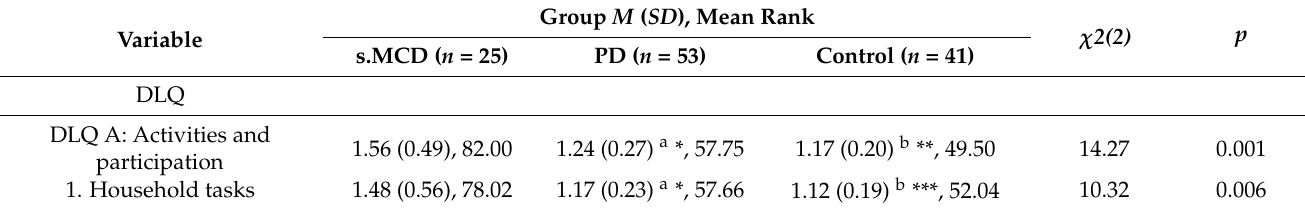
Table 2. Comparison of the DLQ and TOPS scores of the PD patients with (s.MCD group) and without (PD group) suspected mild cognitive decline based on their CF features and healthy control